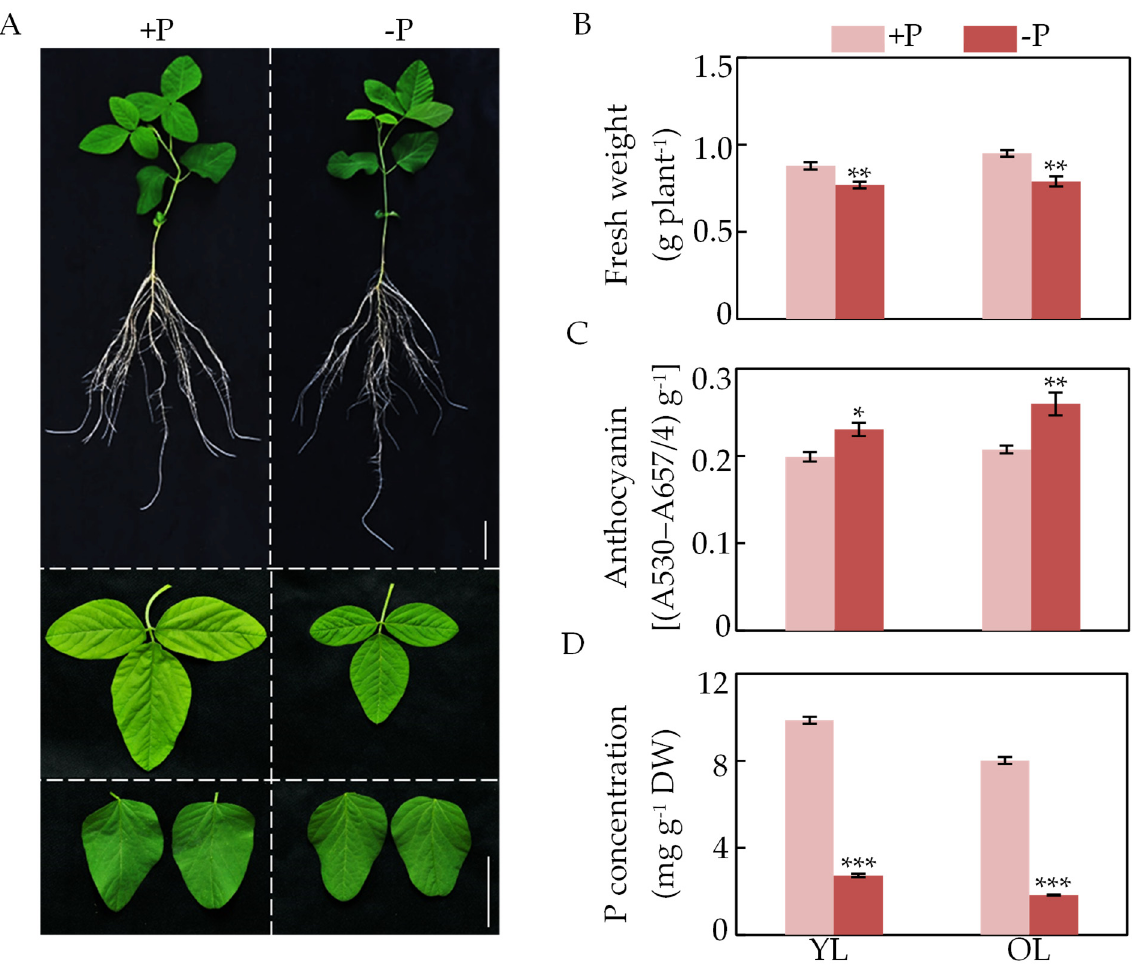
Figure 1. Effects of P deficiency on soybean fresh weight, anthocyanin content and P concentration. ( A ) Phenotypes of soybean at two P levels. Bars = 5 cm. ( B ) Fresh weight of young leaves (YL) and old leaves (OL). ( C ) Anthocyanin content of YL and OL. ( D ) P concentration of YL and OL. Data are means of four replicates ± SE. Asterisks indicate significant difference between the two P levels in the Student’s t -test (* p < 0.05; ** p < 0.01; *** p < 0.001).